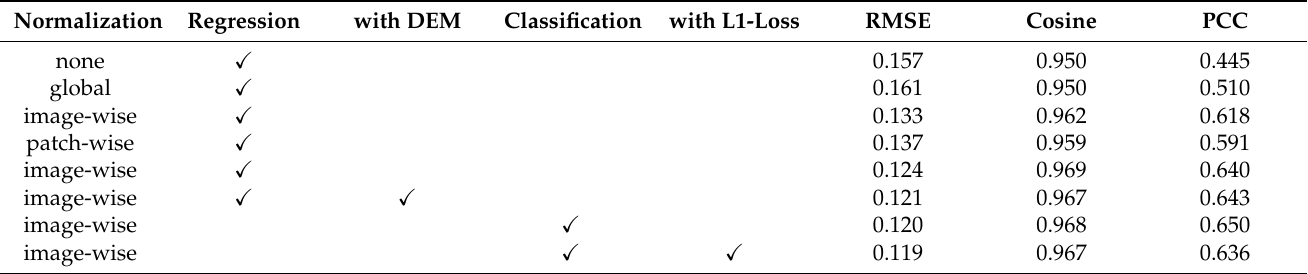
Table 5. Ablation study of different models, with EVC predictions channel-wise scaled to a [0, 1] range for better comparability. Root mean squared error (RMSE), cosine similarity (Cosine),